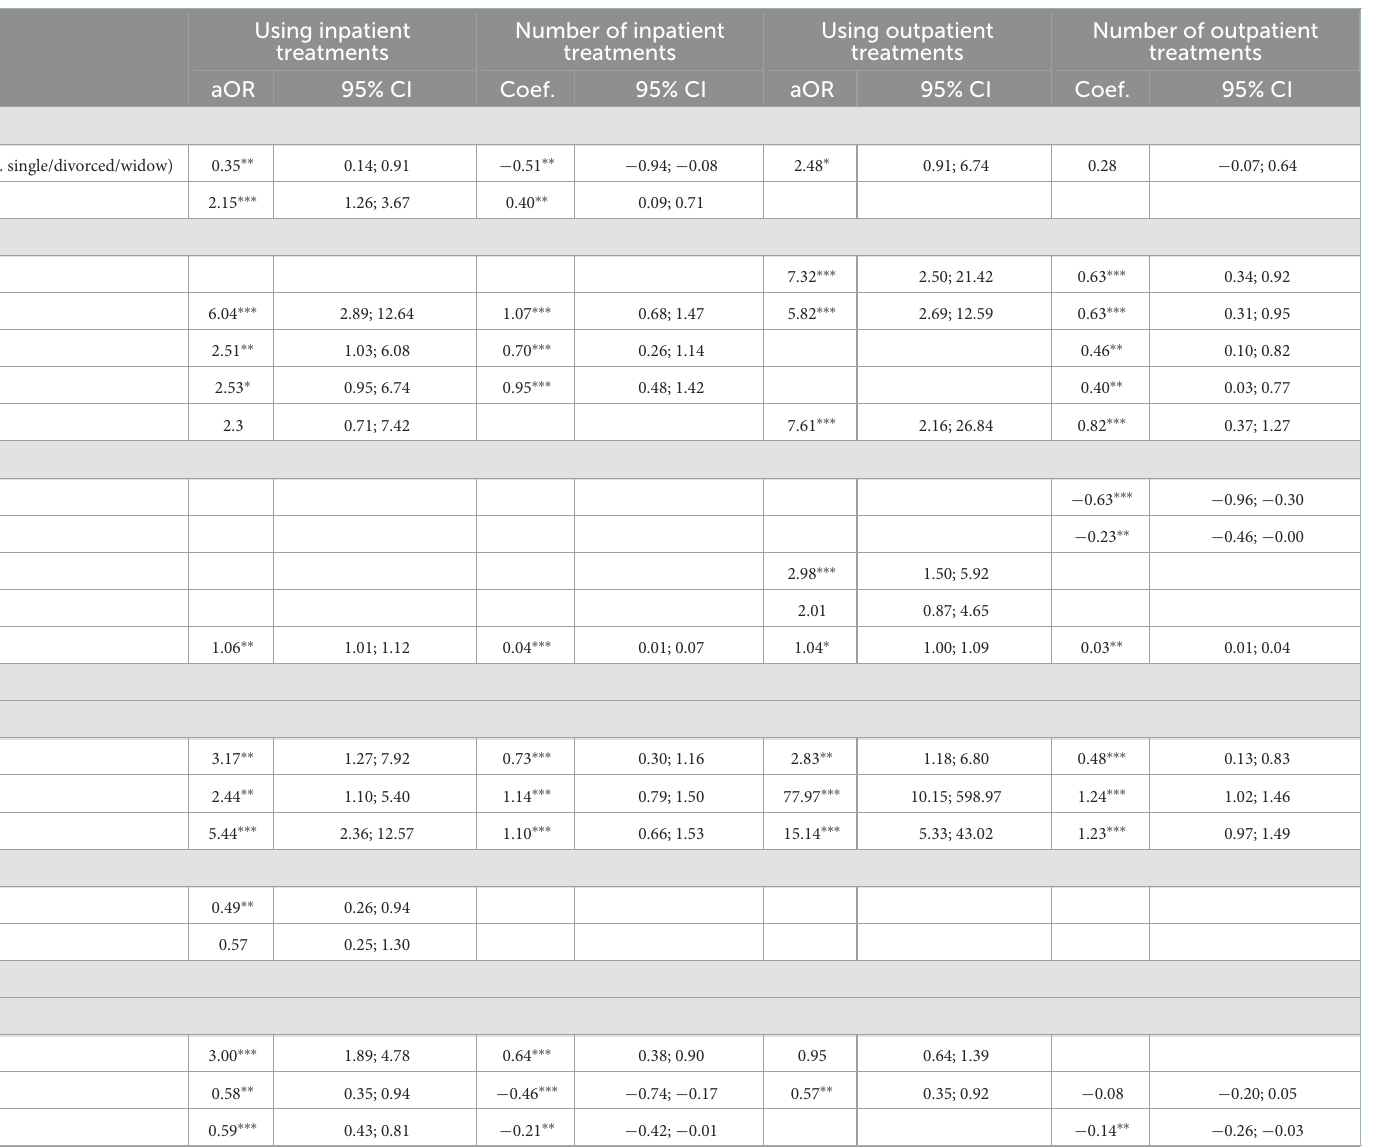
TABLE 3 Associated factors with health service utilization.